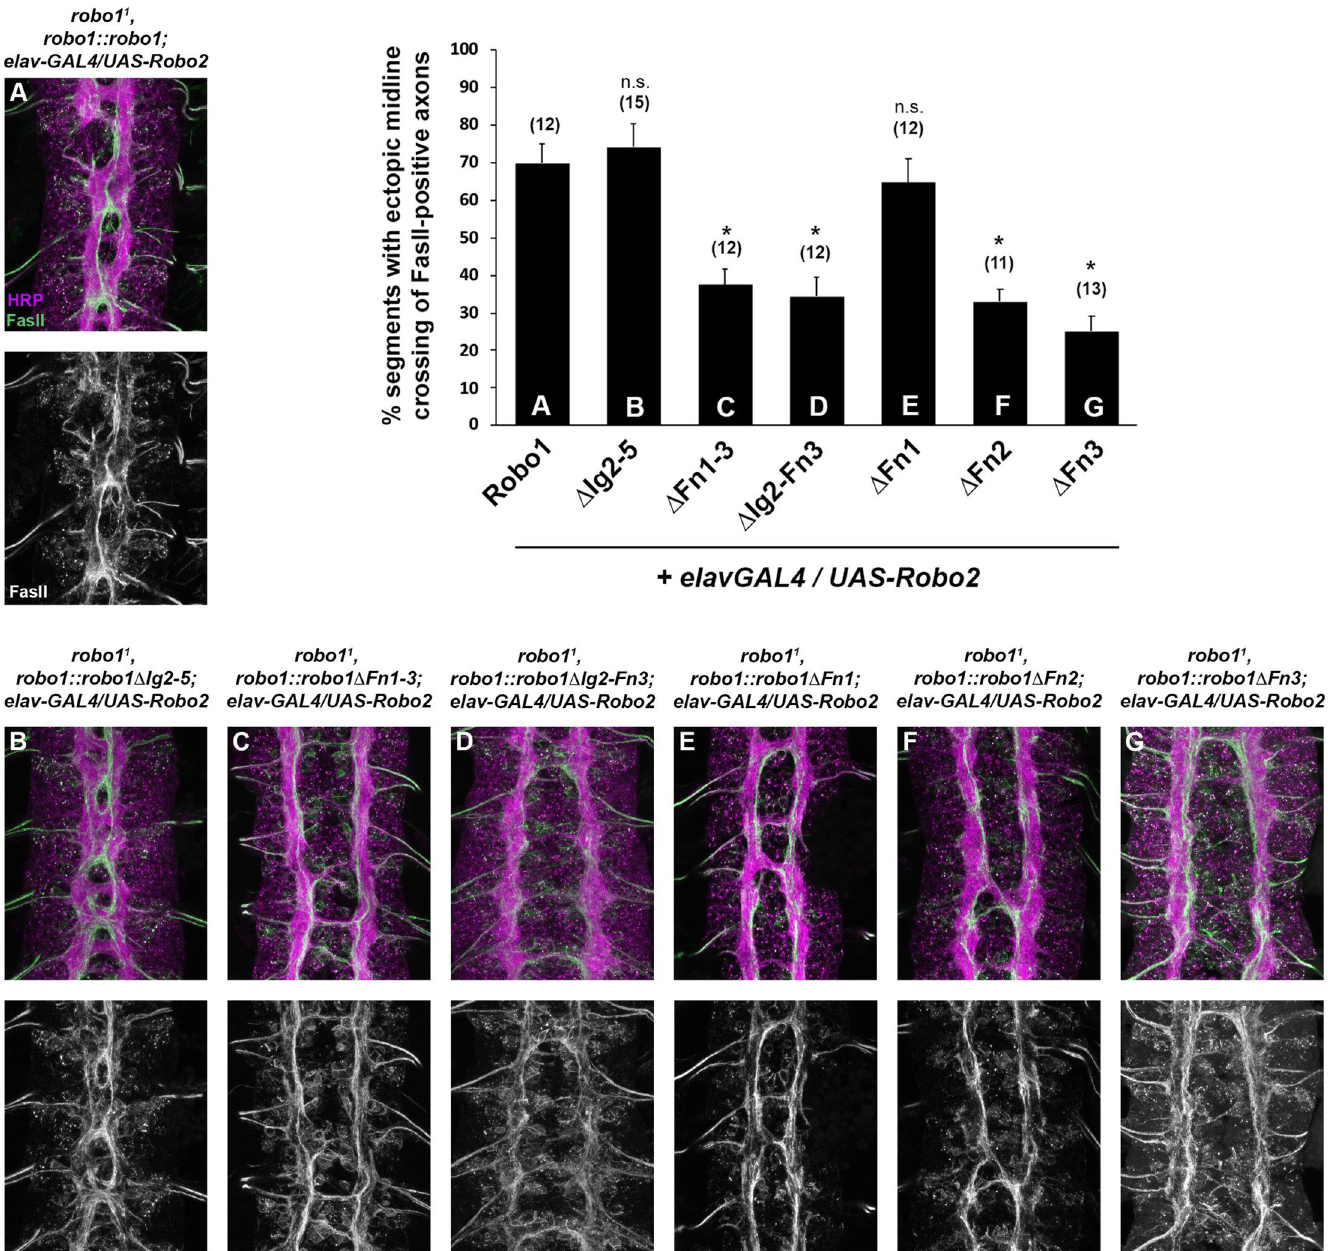
Fig 6. The Fn2 and Fn3 repeats of Robo1 are required for sensitivity to Robo2. Expression of Robo1 and Robo1 variants in a Robo2 misexpression background. Stage 16 embryos stained with anti-HRP (magenta) and anti-FasII (green) antibodies. Misexpression of Robo2 (via elav-GAL4 and UAS-Robo2 ) induces strong ectopic midline crossing of FasII-positive axons in embryos that express full length Robo1 (A), Robo1 Δ Ig2-5 (B), or Robo1 Δ Fn1 (E). However, Robo2 misexpression in embryos expressing Robo1 Δ Fn1-3 (C), Robo1 Δ Ig2-Fn3 (D), Robo1 Δ Fn2 (F), or Robo1 Δ Fn3 (G) instead display a commissureless phenotype with significantly decreased levels of ectopic midline crossing. Qualitatively, the phenotypic differences observed suggest that Robo1 variants lacking any of the Fn repeats are insensitive to transient downregulation by Robo2. Bar graph at top left indicates instances of ectopic crossing in the genotypes shown in (A-G) with sample size of scored embryos (n) listed above each genotype. Error bars indicate s.e.m. Ectopic midline crossing defects caused by Robo2 misexpression in each Robo1 variant background (B-G) were compared to those caused by Robo2 misexpression in a full-length Robo1 background (A) by a two-tailed Student’s t-test, with a Bonferroni correction for multiple comparisons ( � p <